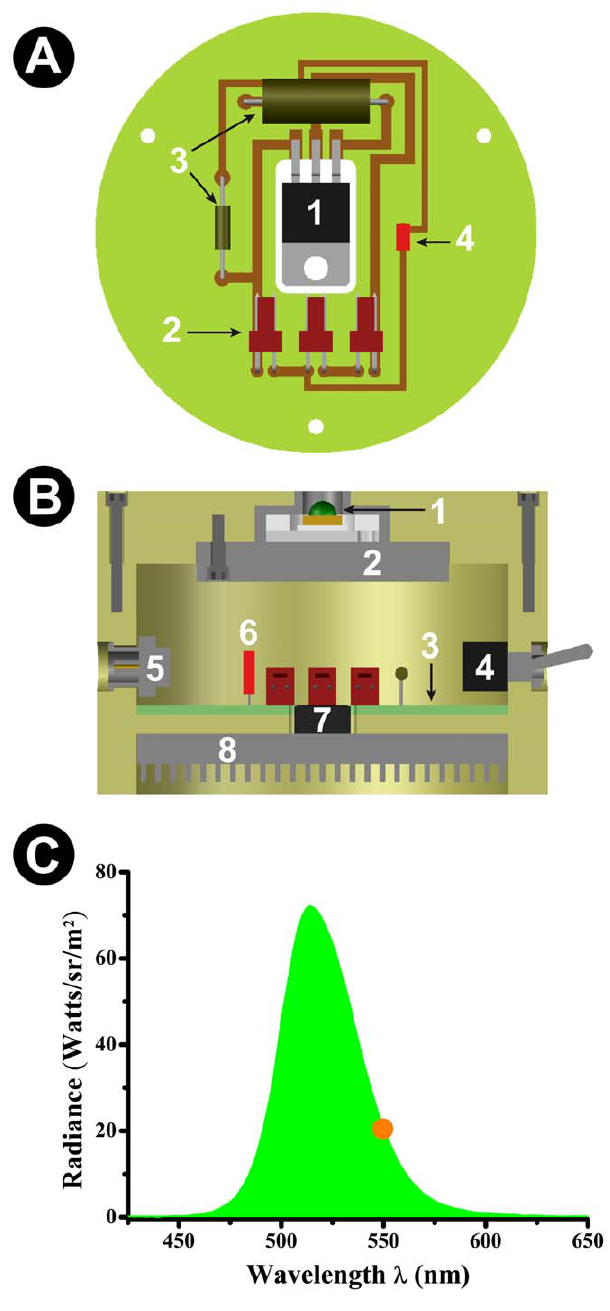
Figure 2. Schematics and function of the photooxidizer. A: Schematic drawing of the PCB. 1: Voltage regulator microchip; 2: Input/ output connectors; 3: Resistors; 4: Red low power LED (indicates power feed). B: Schematic drawing of the internal components of the photooxidizer. This panel represents a vertical transection of the apparatus. 1: Green high power LED (promotes photooxidation); 2: LED chamber heat sink; 3: PCB; 4:On/off switch; 5: Power feed connector; 6: Red low power LED (indicates power feed); 7: Voltage regulator microchip; 8: PCB heat sink. C: Radiance spectrum of the green high power LED used for DiI photoconversion. The orange dot represents the peak absorbance wavelength of DiI, confirming the appropriateness of the used